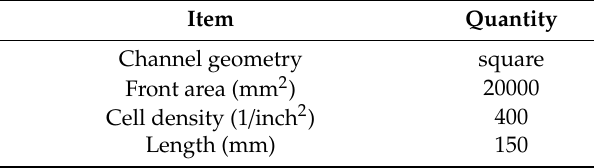
Table 3. Configuration parameters of DOC in GT-power.